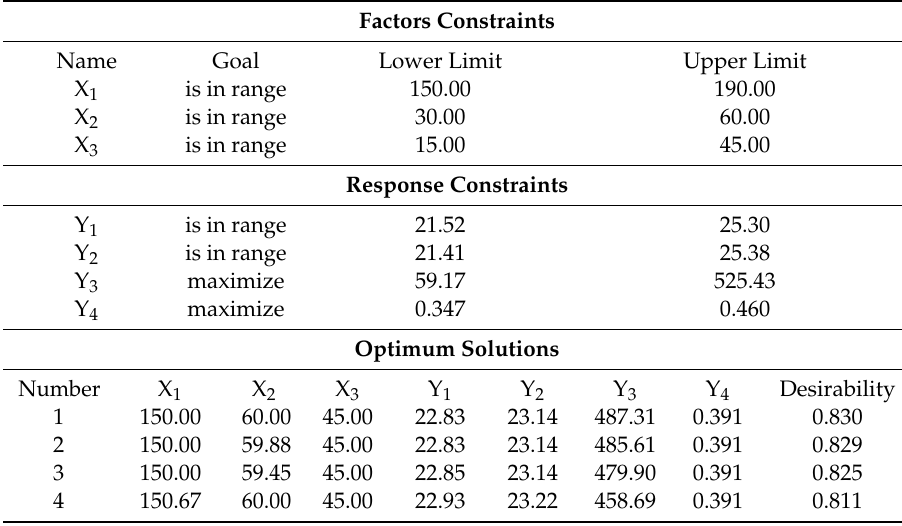
Table 3. The settings and solutions of the numerical optimization criterion. Factors